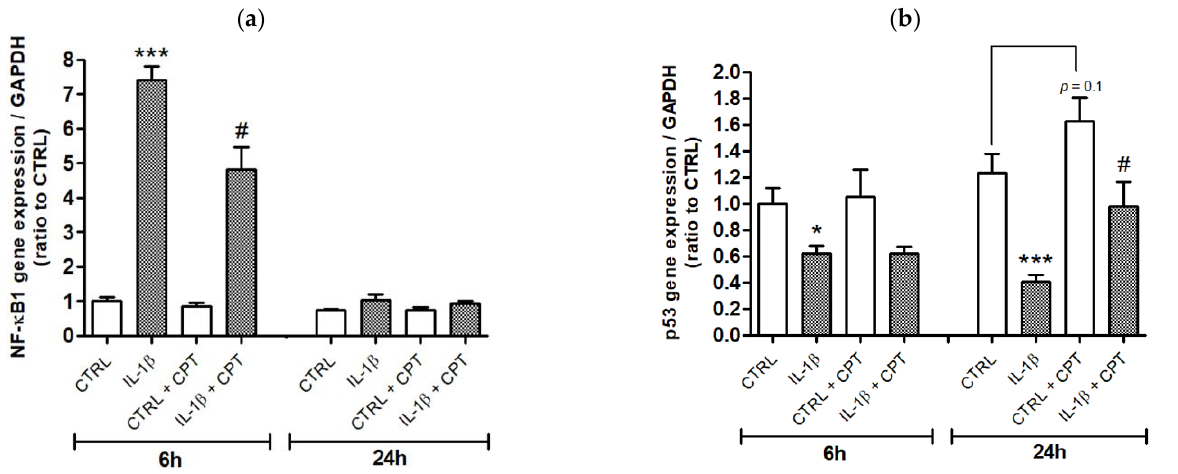
Figure 6. CPT-11 down-regulates IL-1 β -induced NF- κ B1 expression and upregulates an IL-1 β -induced decrease in p53 expression in HSF. ( a ) NF- κ B1 and ( b ) p53 mRNA levels from HSF treated with IL-1 β and co-treated with CPT-11, for 6 and 24 h, were evaluated by RT-qPCR. Results are expressed as mean ± SEM of four independent experiments. Statistical significance is indicated as follows: p -value < 0.05 (*), p -value < 0.001 (***) compared to control at the corresponding time of treatment; p -value < 0.05 (#) compared to the corresponding treatment without CPT-11.